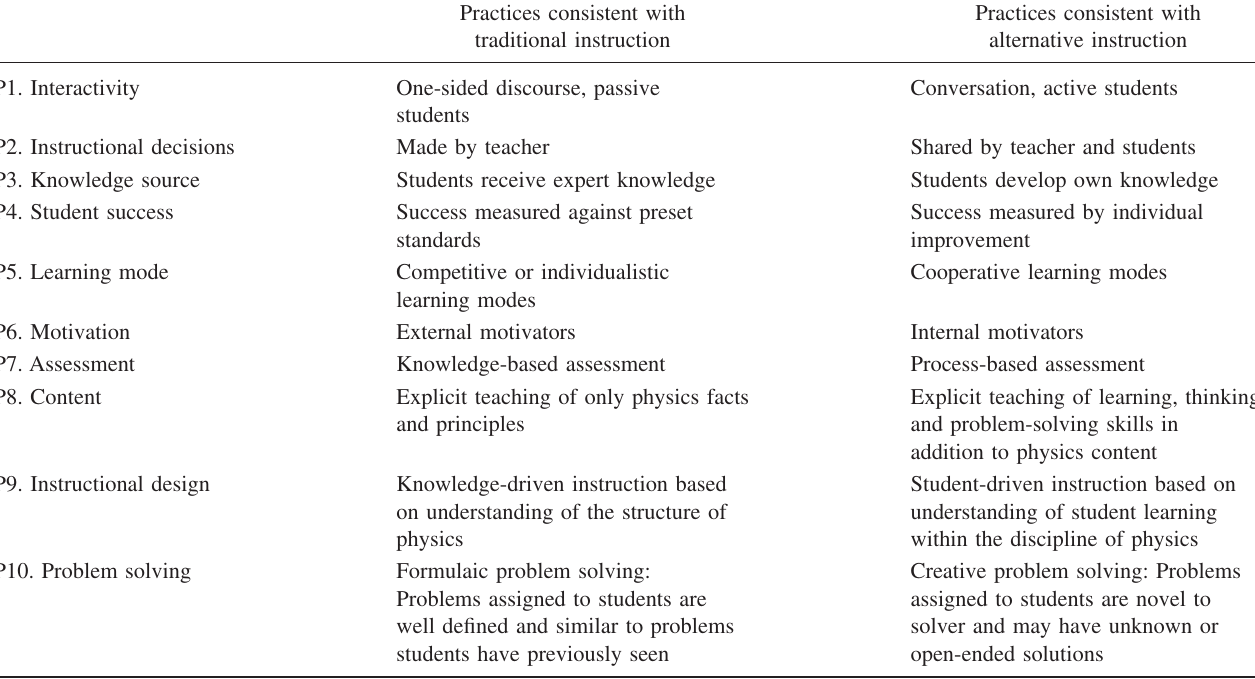
TABLE I. Main categories of practices. Practices consistent